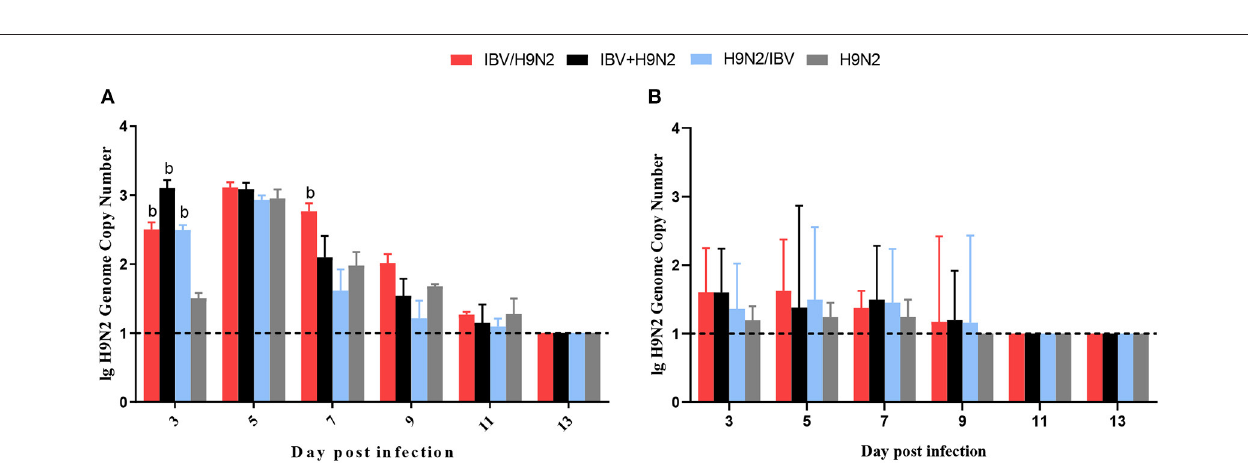
FIGURE 8 | Viral shedding of H9N2 virus. To investigate the viral shedding of H9N2 virus, oropharyngeal (A) and cloacal (B) swabs were collected for virus detection at 3, 5, 7, 9, 11, and 13 dpi using one-step RT-qPCR. Data are presented as means ± SD. “b” indicates a significant difference ( P < 0.05) between the three co-infection groups and the H9N2 group. Dashed black lines indicate the lower limit of detection. RT-qPCR, quantitative reverse transcription polymerase chain reaction; SD, standard